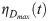
Examplary trajectories for time-varying drug effects.The left panels show an example of an infection event, whereas the right panels show an example of viral extinction for chronic PrEP with 2mg DTG and 5% adherence. Panels A and C depict the instantaneous target-process inhibition profiles and panels B and D depict the corresponding viral trajectories using the adapted EXTRANDE algorithm. Viral exposure occurs randomly during a 3 month period and is sampled from the distribution parameterized in [11] (Figure 2 therein). A&C: The blue lines depict the instantaneous target-process inhibition profiles ηD(t). The dashed red line denotes the maximum target-process inhibition ηDmax(t). The leftmost grey vertical dashed lines mark the time of viral exposure, whereas the rightmost lines marks the time point of either establishment of infection (panel A) or virus extinction (panel C). B&D: Stochastic trajectories of viral compartments (orange: free viruses, green: early-infected cells T1, purple: late-infected T2 cells) for the time after virus exposure and before virus infection/extinction. Stochastic simulations are stopped in panel B when the trajectories leave the extinction simplex and because of virus extinction in panel D.